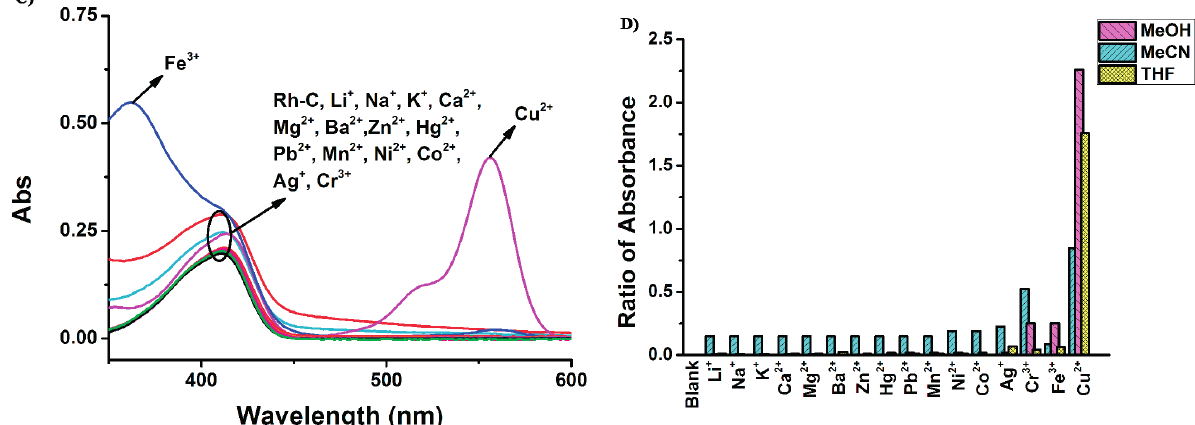
Figure 2. The UV-Vis absorption of Rh-C (5 μ M) upon addition of different metal ions (100 μ M). ( A ) in MeOH; ( B ) in MeCN; ( C ) in THF; ( D ) The ratiometric absorption of Rh-C (5 μ M) upon addition of different metal ions (100 μ M. MeOH: A 554 /A 420 , MeCN: A 558 /A 415 , THF: A 556 /A 410 ).